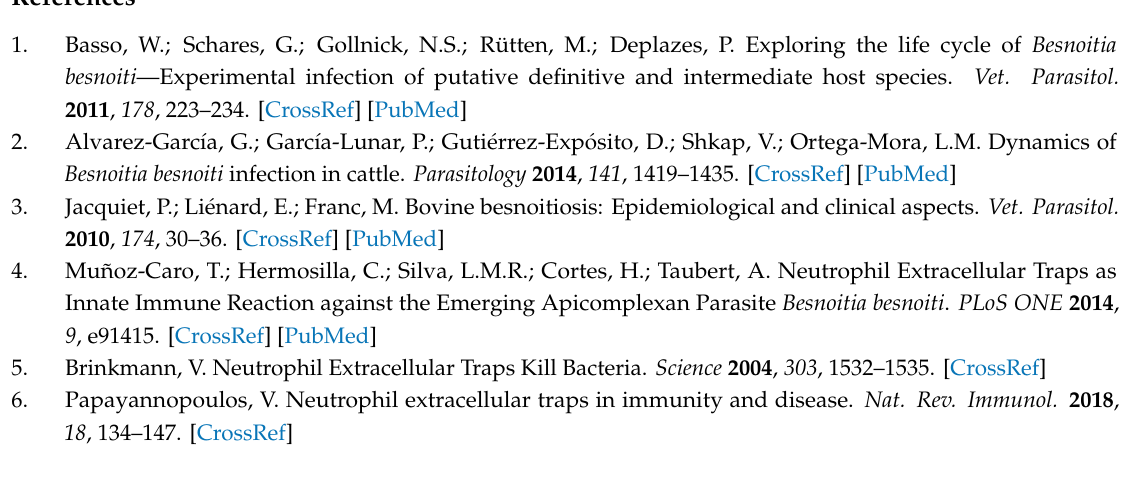
Figure S1: Immunofluorescence on PMN releasing NETs in response to A23187 5 and 25 µ M and determination of % of PMN releasing NET in these conditions. Figure S2: Estimation of the % of PMN releasing NETs in response to B. besnoiti tachyzoites and PMA 100 nM. Figure S3. Additional Images of DAPI / Isolectin IB4 staining of experimental conditions. Figure S4. Additional figures showing B. besnoiti tachyzoites inducing bovine NETs. Figure S5. Workflow illustrating the procedure of image analysis to obtain endothelial damage percentages shown in Figure